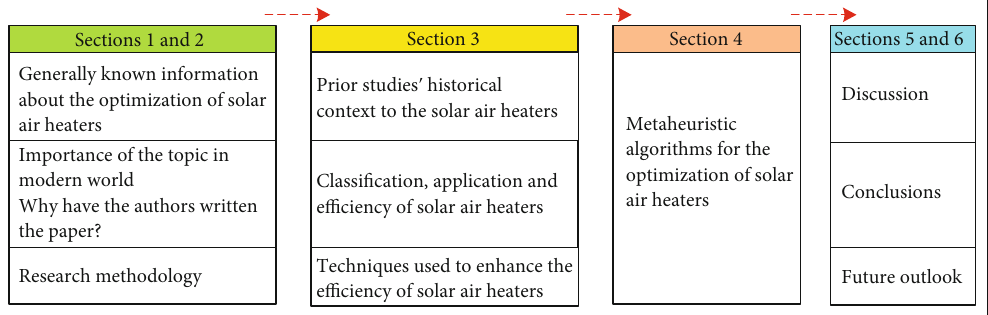
Figure 1: Roadmap of this